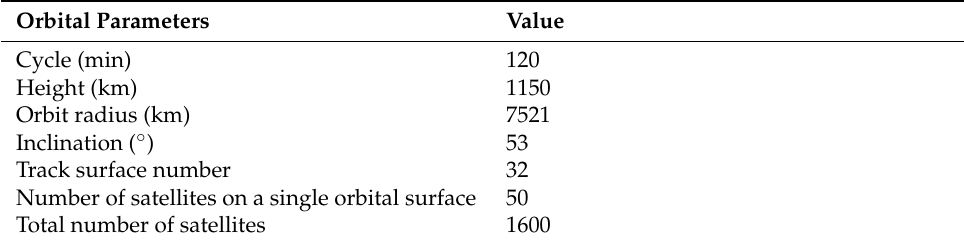
Table 1. Main parameters of the system.